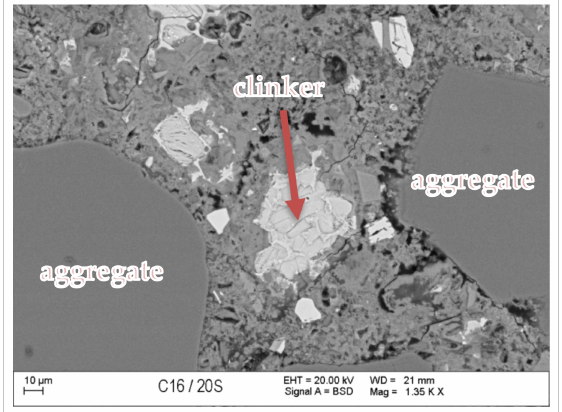
Figure 13. BSE image of RMUD concrete sample.